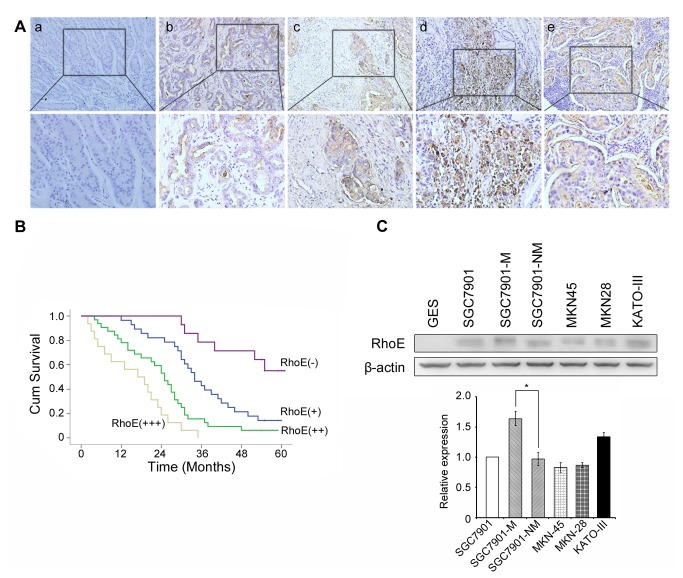
Expression of RhoE in gastric cancer tissues and cells, and its association with patient survival.(A), Immunohistochemical analysis of RhoE in tissues; (a), normal gastric epithelium; and (b) well-differentiated, (c) moderately differentiated or (d) poorly-differentiated gastric cancer tissue; (e) metastatic site in the lymph node. Brown coloration represents positive RhoE staining. (B), Kaplan- Meier post-operative survival curve as a function of RhoE expression. (C), Western blot analysis of RhoE expression in different gastric cell-lines. β-actin was used as the internal control. The relative expression levels of RhoE in gastric cancer cell-lines were presented as bar charts. * P <0.05.